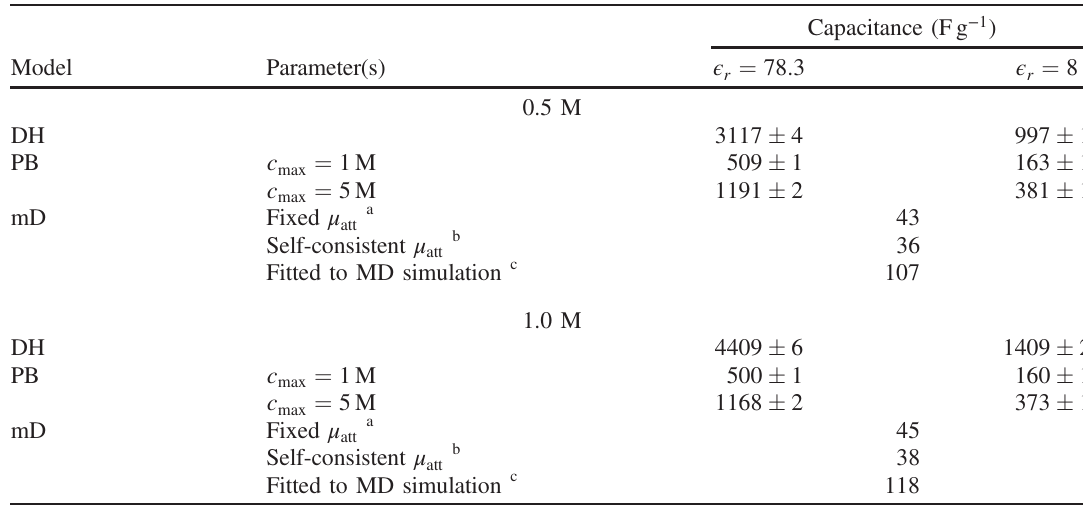
TABLE II. Single-electrode capacitance in F g − 1 from DH, PB, and mD theories. Here, c is the maximum max concentration allowed in the PB theory, accounting for volume saturation in Ref. [76] For the modified Donnan model, with fixed or self-consistent attraction parameter μ , we use values from the literature for similar materials att for the Stern capacitance parameters C and α (see text), and the electrode capacitance is computed from the St ; vol ; 0 charge of a symmetric electrochemical cell under a voltage of 1.0 V. Uncertainties are based on that for the specific surface